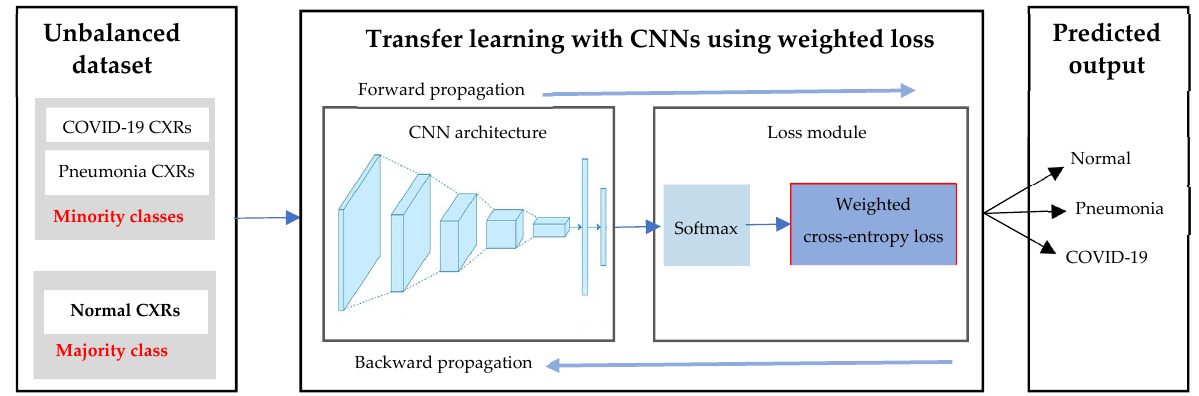
Figure 7. Transfer learning of CNNs with the weighted loss on the unbalanced dataset.